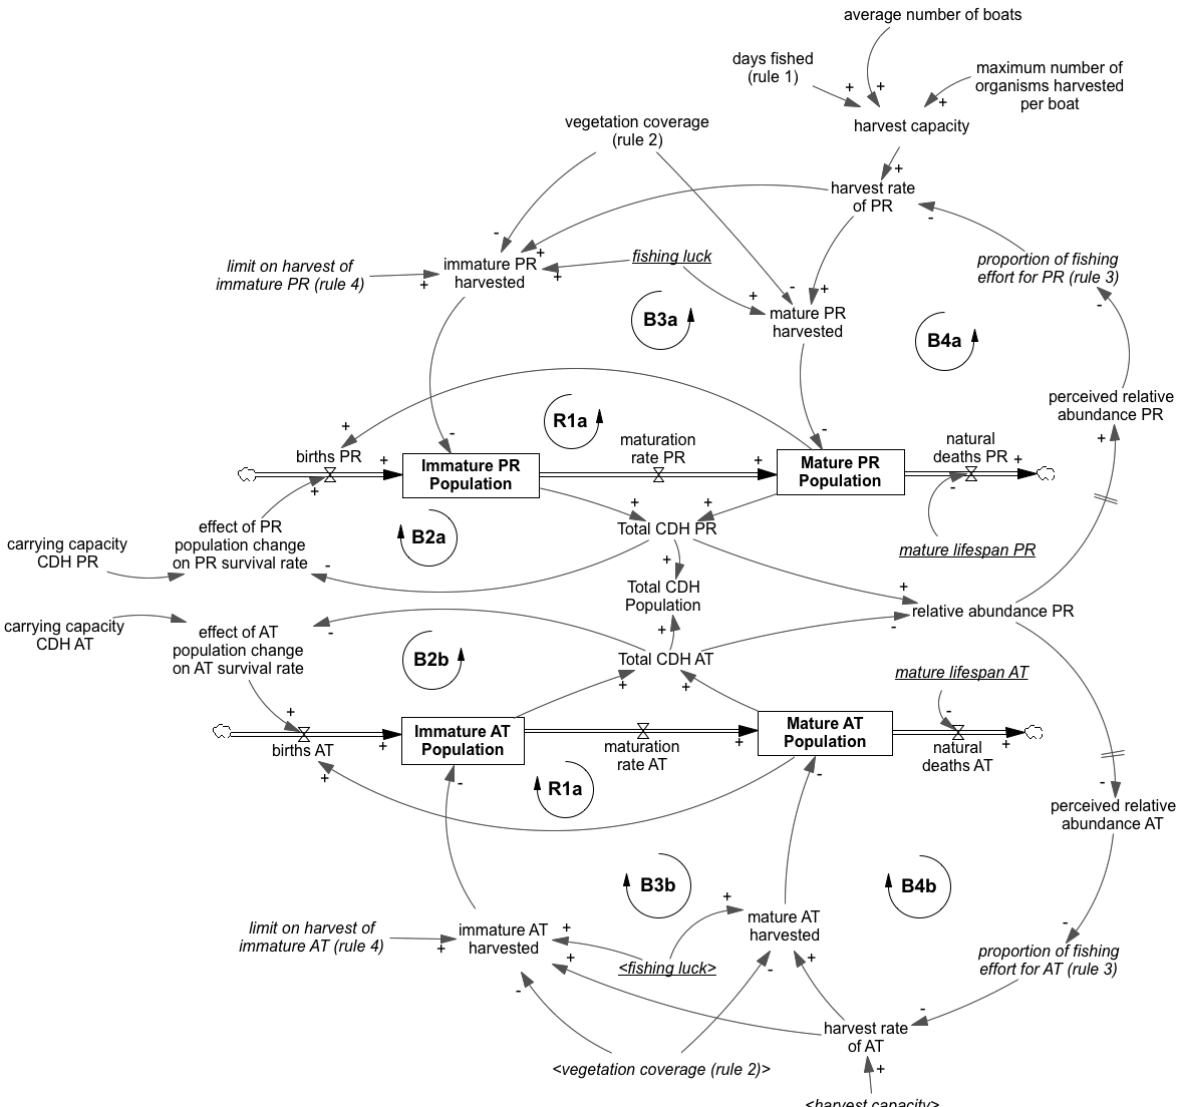
Fig. 2 . Causal loop diagram showing the feedback loops and key variables in the model. Each arrow has a positive sign (+) or negative sign (–), which signifies whether an increase in the variable at the root of the arrow creates an increase or decrease in the variable at the terminus of the arrow. The variables that were altered in our experiments are italicized, with the stochastic variables also underlined. Variables in the lower half of the figure with < > around them correspond to the identically named variables in the top half; they are repeated to enhance readability. Pr refers to Pinna rugosa , At refers to Atrina tuberculosa , and CDH refers to Callos de Hacha, or the entire pen shell population, including both species. R: positive, or reinforcing, feedback loop; B: negative, or balancing, feedback